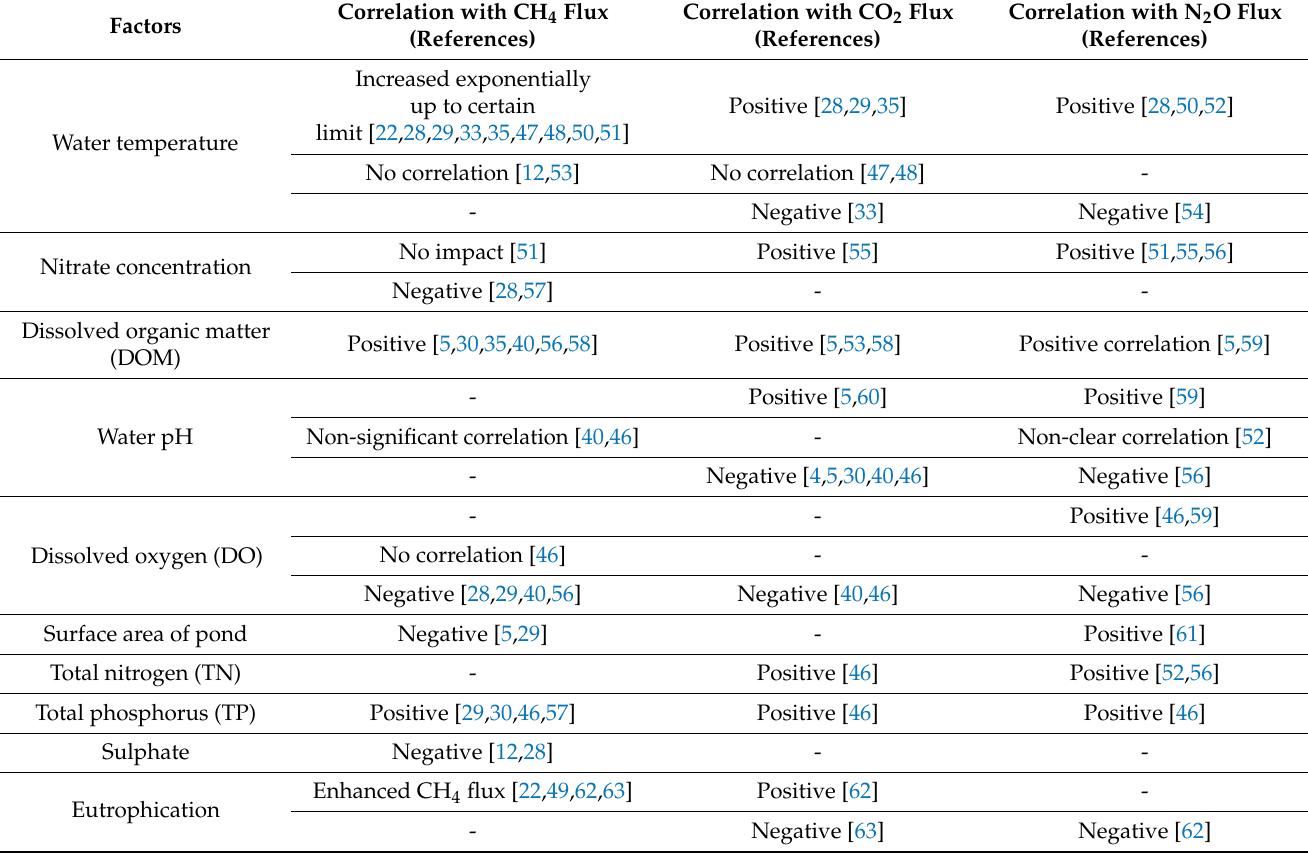
Table 2. Impact of different factors on greenhouse flux from water